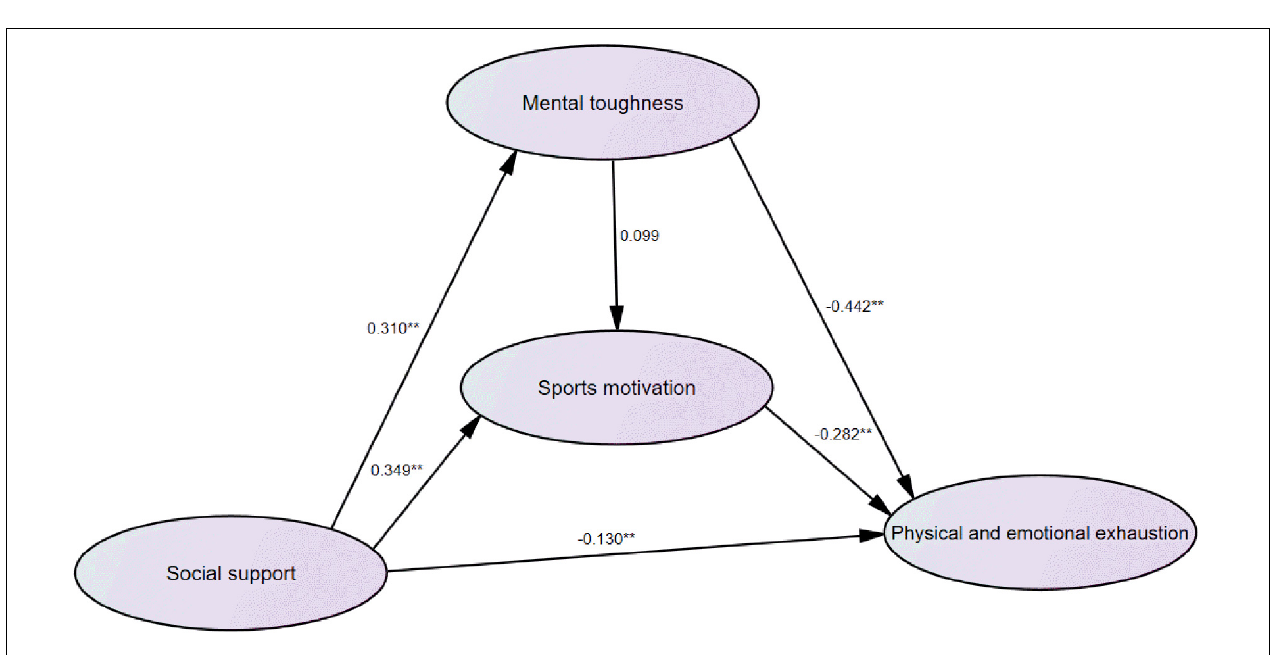
FIGURE 3 | Schematic diagram of path analysis of social support, sports motivation, mental toughness, and physical and emotional exhaustion. **P <